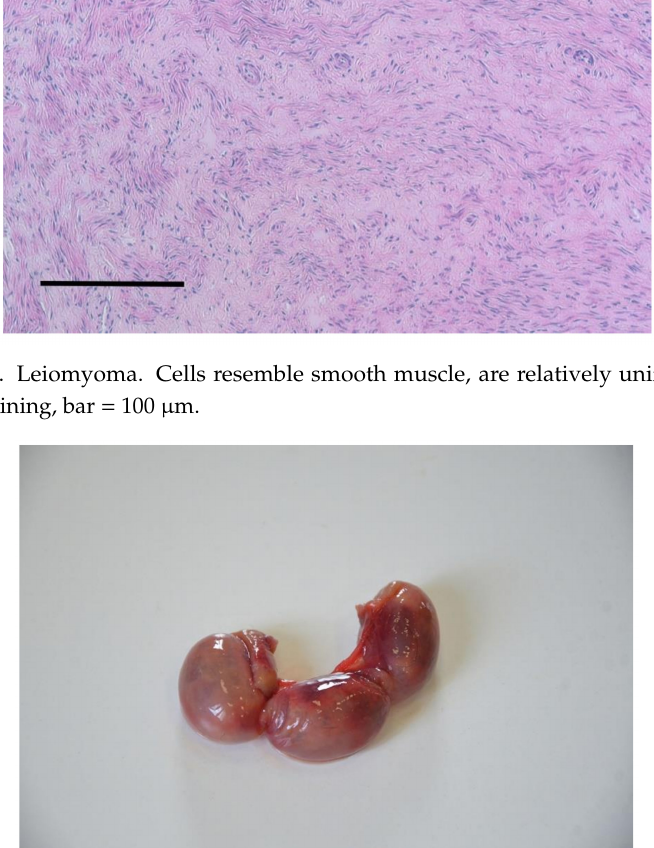
Figure 10. Uterus. Pregnant